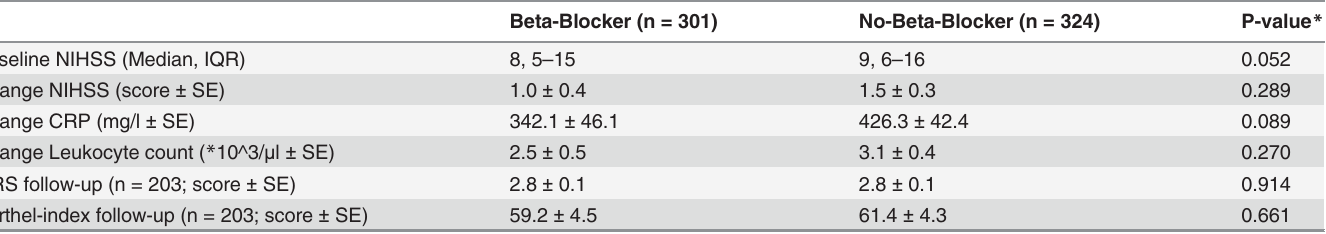
Table 4. C-reactive protein, leukocyte count, NIHSS, modi fi ed ranking scale and Barthel-index in patients with and without beta-blocker therapy (n =